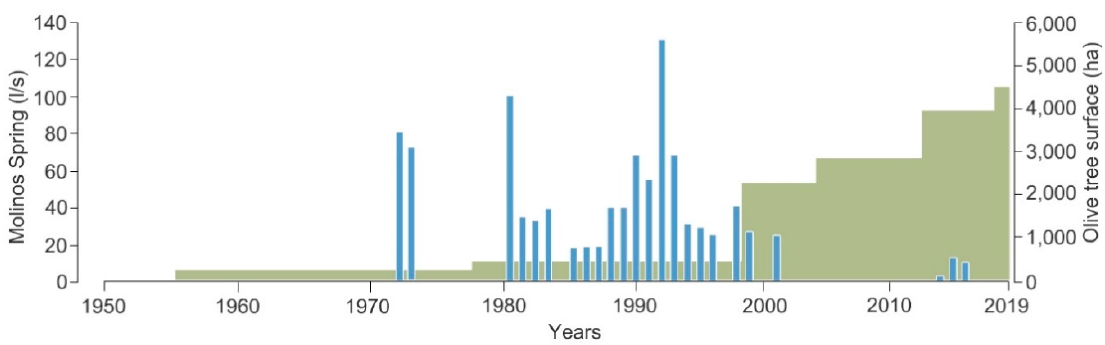
Figure 2. Temporal evolution of the olive grove surface under irrigation (green surface) (obtained from